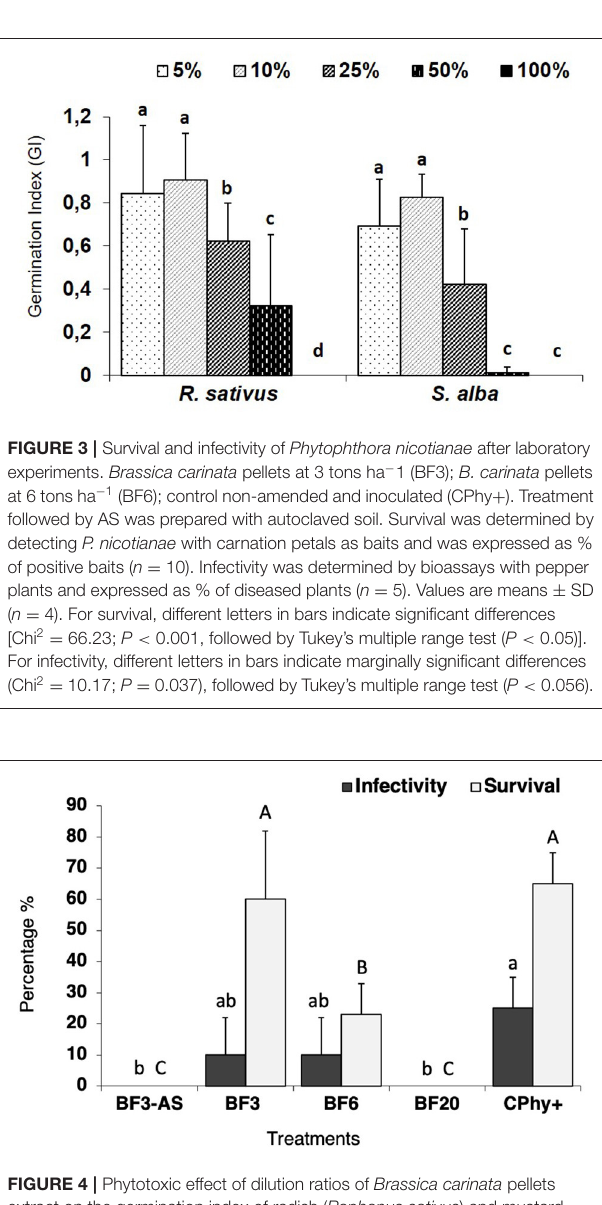
FIGURE 4 | Phytotoxic effect of dilution ratios of Brassica carinata pellets extract on the germination index of radish ( Raphanus sativus ) and mustard ( Sinapis alba ). Values are means ± SD ( n = 10). For each species, bars with a different letter are significantly different [ANOVA ( P < 0.05) followed by Tukey’s multiple range test ( P <